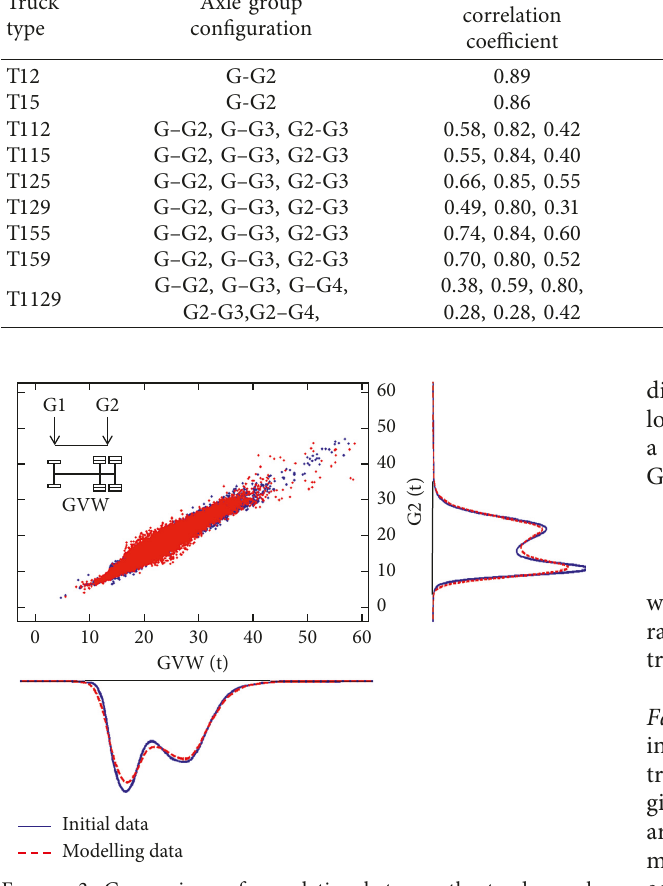
Figure 3: Comparison of correlation between the tandem axle weight (G2) and GVW (G) for the T15 truck type as determined using the raw data and t-copula